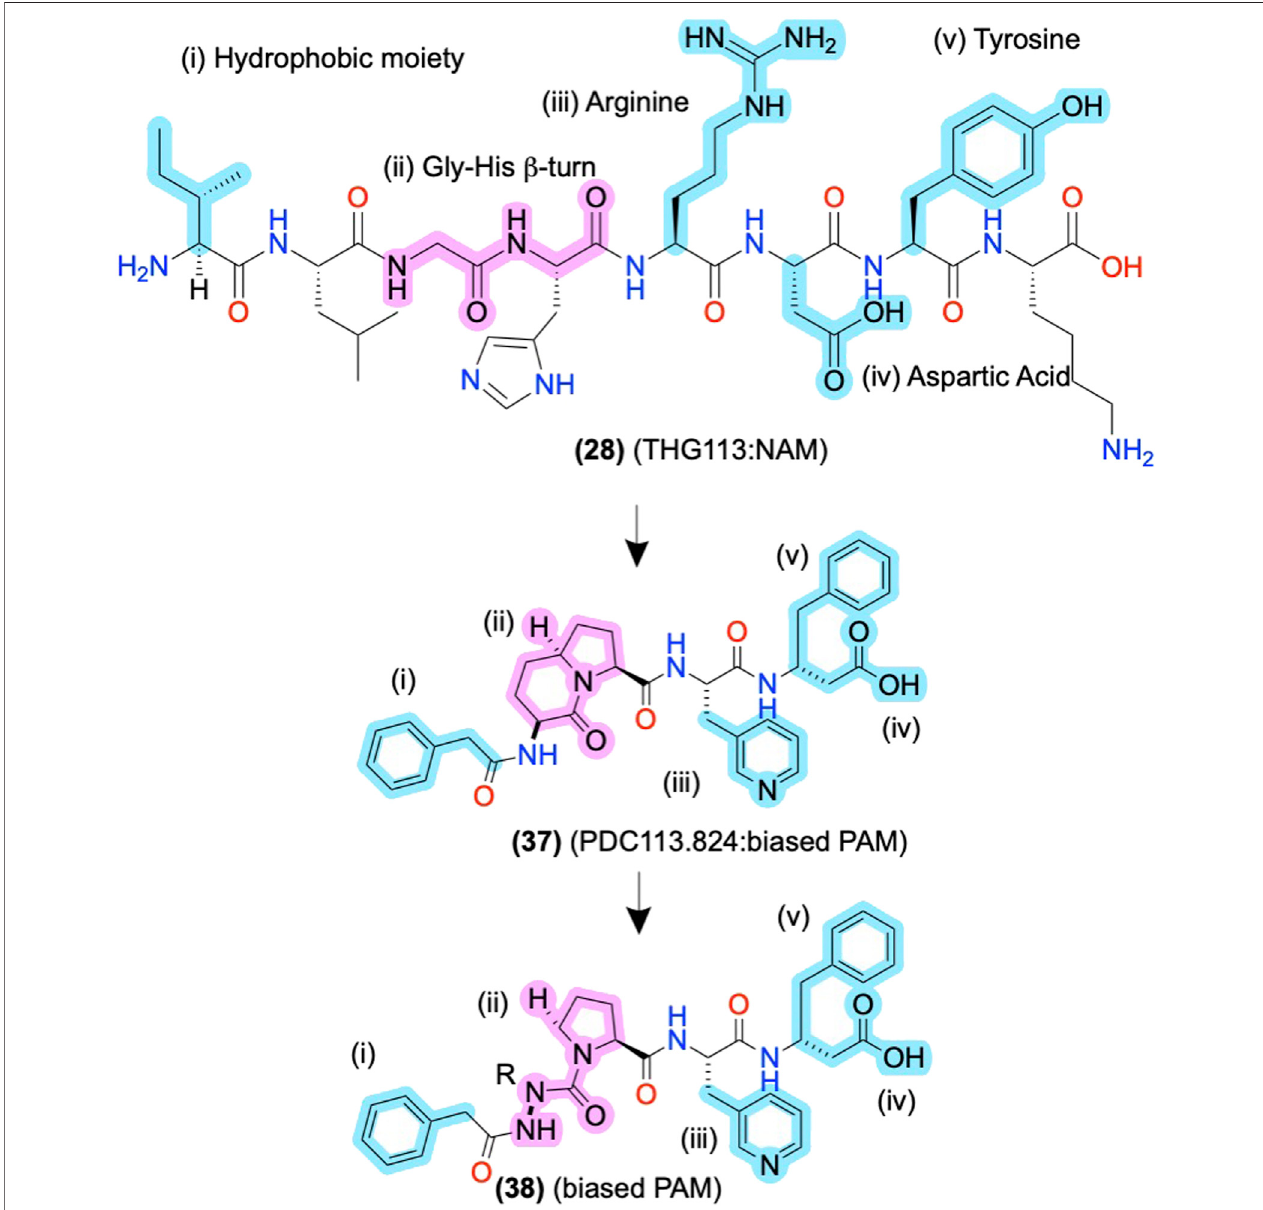
FIGURE 8 | ECL-derived sequences and peptidomimetic design of NAMs and biased-PAMs at FP. The key pharmacophore features are highlighted in yellow and numberedi,ii,iii,andiv,showingthepeptidomimeticdevelopmenttoimprovebioactivity,conformationalstability,andmetabolicstability. Thein-textcompoundnumber isbold,followedbyoriginalname:activity.StructuresareoriginallyreportedbyPerietal.,2002;Bourguetetal.,2009;andGoupiletal.,2010.Sidechainpharmacophore features are labeled in cyan and backbone features labeled in pink. Figure was created with Chemdraw20.0.